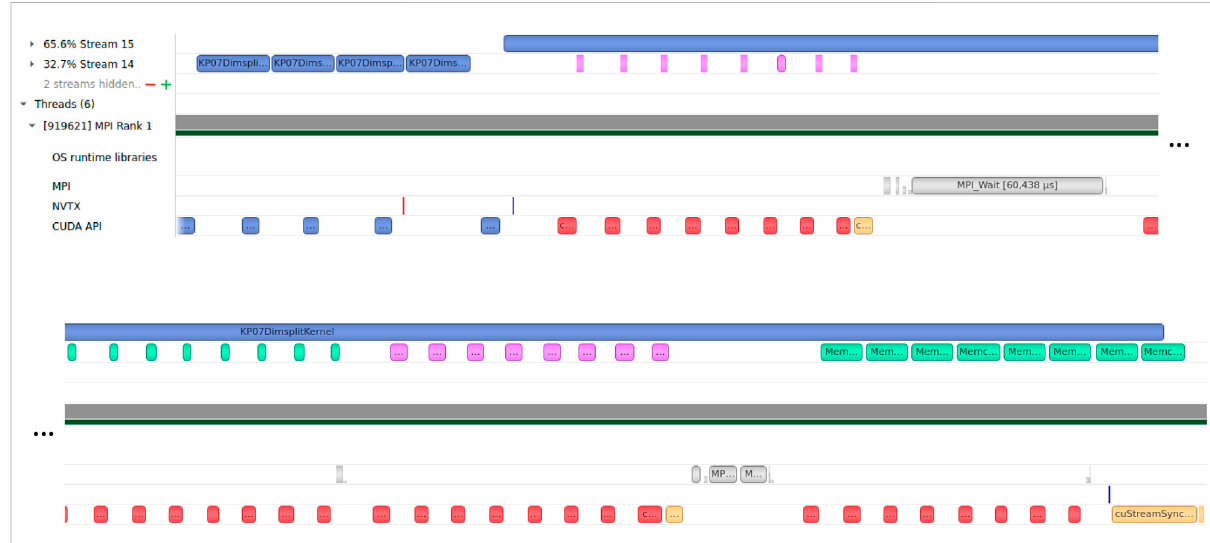
FIGURE 6 Screendump of timeline in the Nsight Systems UI zoomed in on one time step on one GPU (in a two-GPU simulation), showing overlap of memory operations (in Stream 14) and MPI communication (designated MPI), and the computational kernel for the inner domain (in Stream 15). The CUDAAPIcallsareshowninthebottomrow.Notethatthetimelineissplitovertworows.Thecolorcodesforthebarsareasfollows:Blueiscompute kernel execution or API call, purple is download (GPU to CPU), green is upload (CPU to GPU), gray is MPI Isend/Irecv or wait, red is memory API calls, and yellow is CUDA thread synchronization.